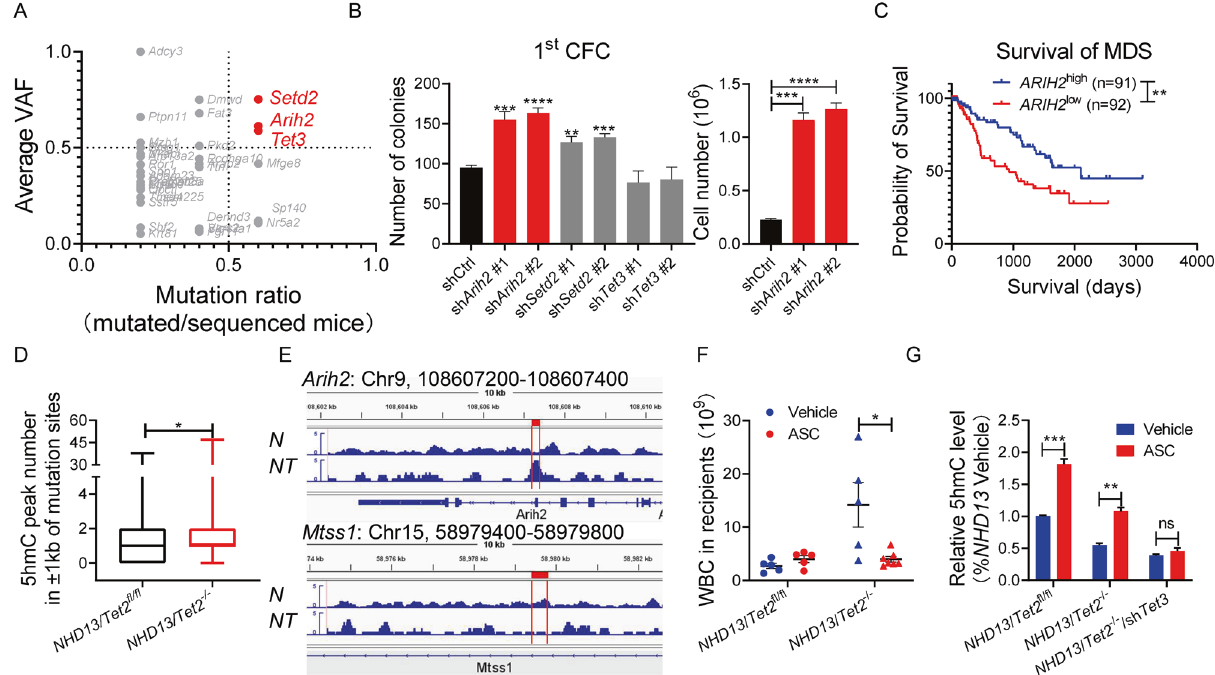
Fig. 2 Vitamin C treatment mimics Tet2 restoration and blocks leukemogenesis. A Depicted are 37 genes identi fi ed from PRECOG based on two conditions (VAF > 50%, mutation ratio >0.5). Red dots represent preferential enrichment of mutations associated with AML poor prognosis. B c-kit + BM cells from NHD13 mice were transduced with shRNA targeting indicated genes and then plated for CFC. Shown are colony number (left) and cell number (right) of sh Arih2 or shCtrl cells after fi rst plating. C Overall survival of total MDS patients, strati fi ed by ARIH2 expression levels. D 5hmC peaks around mutation sites (±1 kb) were counted in Tet2 -WT or Tet2 -KO NHD13 mice ( P = 0.0265, paired t test). E Representative University of California Santa Cruz (UCSC) tracks showing 5hmC peaks (red boxes) associated with Arih2 (Chr9: 108607200 – 108607400) and Mtss1 (Chr15: 58979400 – 58979800) loci. Tracks showing 5hmC enrichment were from biological replicates of BM c-kit + cells from NHD13 / Tet2 -WT (N) or NHD13 / Tet2 -KO (NT) mice. F Vitamin C treatment of mice reconstituted with NHD13 / Tet2 fl / fl and NHD13 / Tet2 fl / fl / Mx1 -Cre BM. Tet2 was deleted by injection of poly(I:C) at 6 weeks post-transplant. Mice were intraperitoneally injected with normal saline (vehicle) or ascorbate (ASC, 4 g/kg), 5 days a week for 16 weeks. WBC counts were monitored at 24 weeks post-transplant. G NHD13 / Tet2 fl / fl , NHD13 / Tet2 -/- , and NHD13 / Tet2 -/- /sh Tet3 BM c-kit + cells were treated with vehicle or ASC (0.25 mM) for 3 days and relative 5hmC levels in total DNA were measured by ELISA. * P < 0.05; ** P < 0.01; *** P < 0.001; **** P <